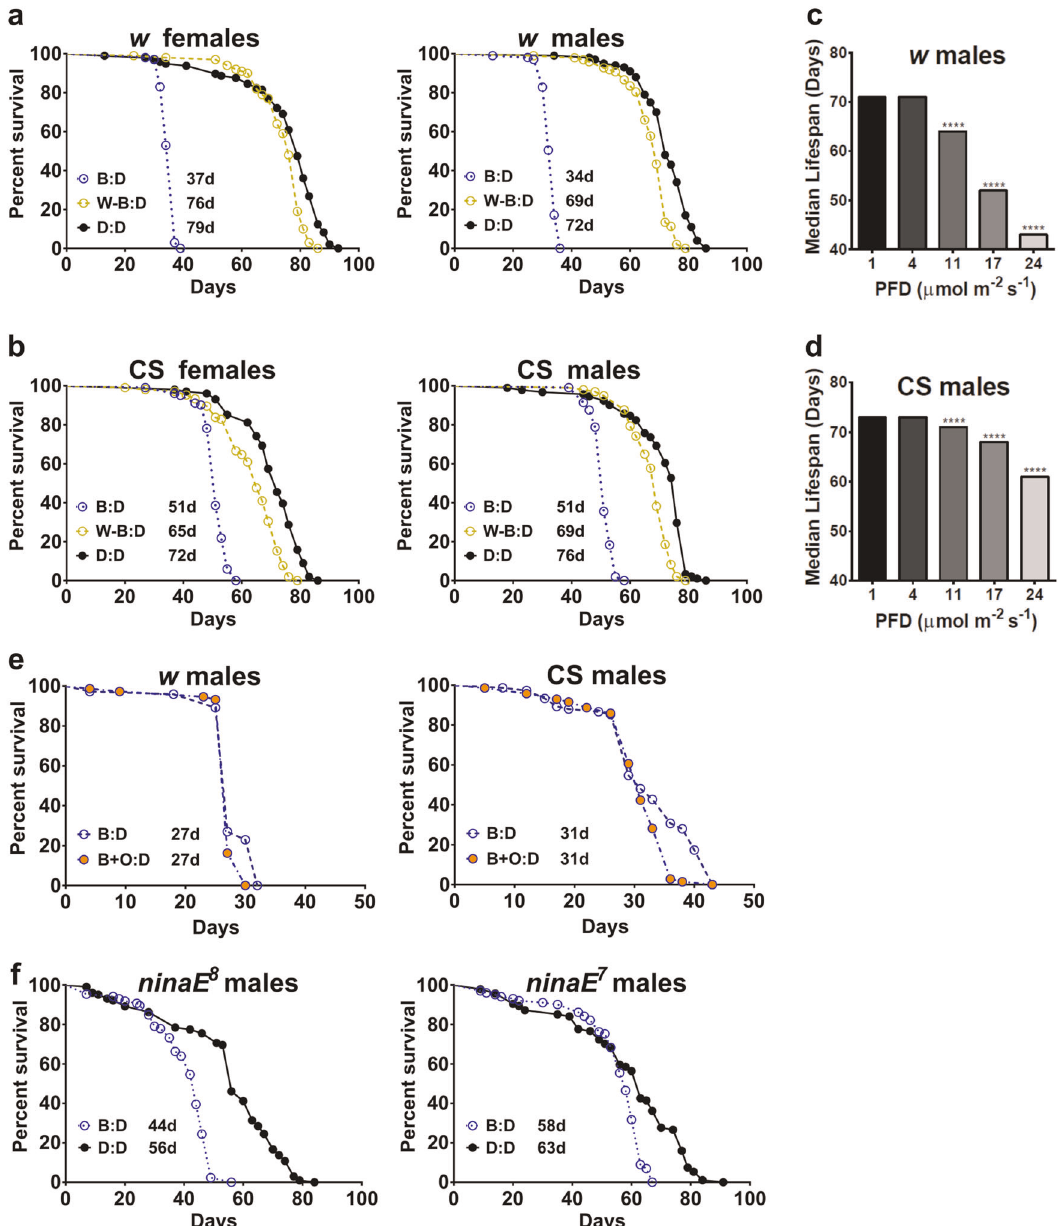
Fig. 2 Light in the blue spectrum is responsible for the decrease in fl y lifespan. Lifespan of w a and CS b fl ies is dramatically reduced in B:D compared with D:D (Log-rank test, p < 0.0001), but minimally reduced in fl ies aged under white LEDs lacking blue wavelengths by means of a yellow fi lter (W – B:D). Median lifespan of w c and CS d fl ies in B : D is reduced with increasing photon fl ux density (PFD). Statistics shown are from pairwise comparisons of the corresponding mortality curves that showed a dose-dependent effect, increasing PFD from 4 to 11, from 11 to 17, and from 17 to 24 µmol each, causing a signi fi cant increase in mortality (Log-rank tests with Bonferroni multiple correction, p < 0.0001). Note that the y axis does not start at 0 to highlight these differences in median lifespan. e Survival of w and CS males kept in B:D or in B:D with added orange light (B + O:D). f Mortality curves of the white-eyed ninaE 8 and red-eyed ninaE 7 mutants in B:D and D:D. In all of the above experiments, N = 100 for each genotype and light